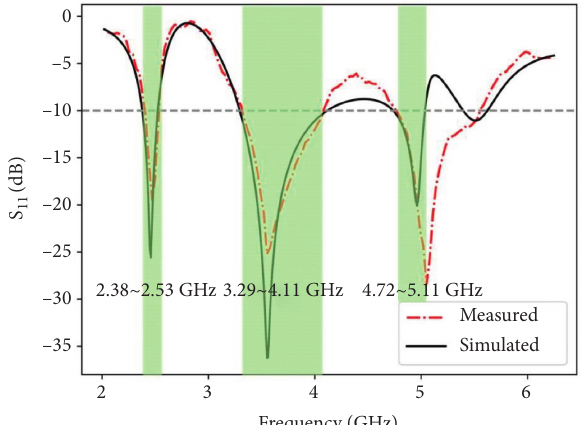
Figure 6: Simulated and measured reflection coefficients S proposed